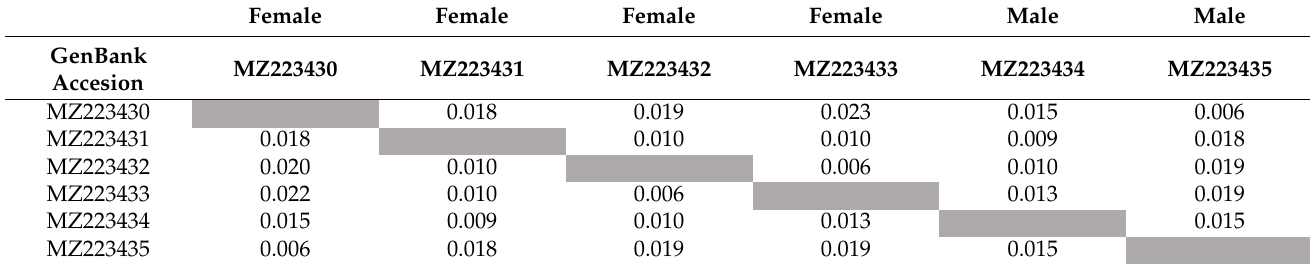
Table 4. Pair-wise genetic distances between monstrilloid copepods from Rio das Ostras (Sate of Rio de Janeiro, Brazil) based on 681 pb COI (cytochrome c-oxidase, subunit I) fragment. Distances: (below diagonal) p -distance; (above diagonal) Tamura-Nei distance.